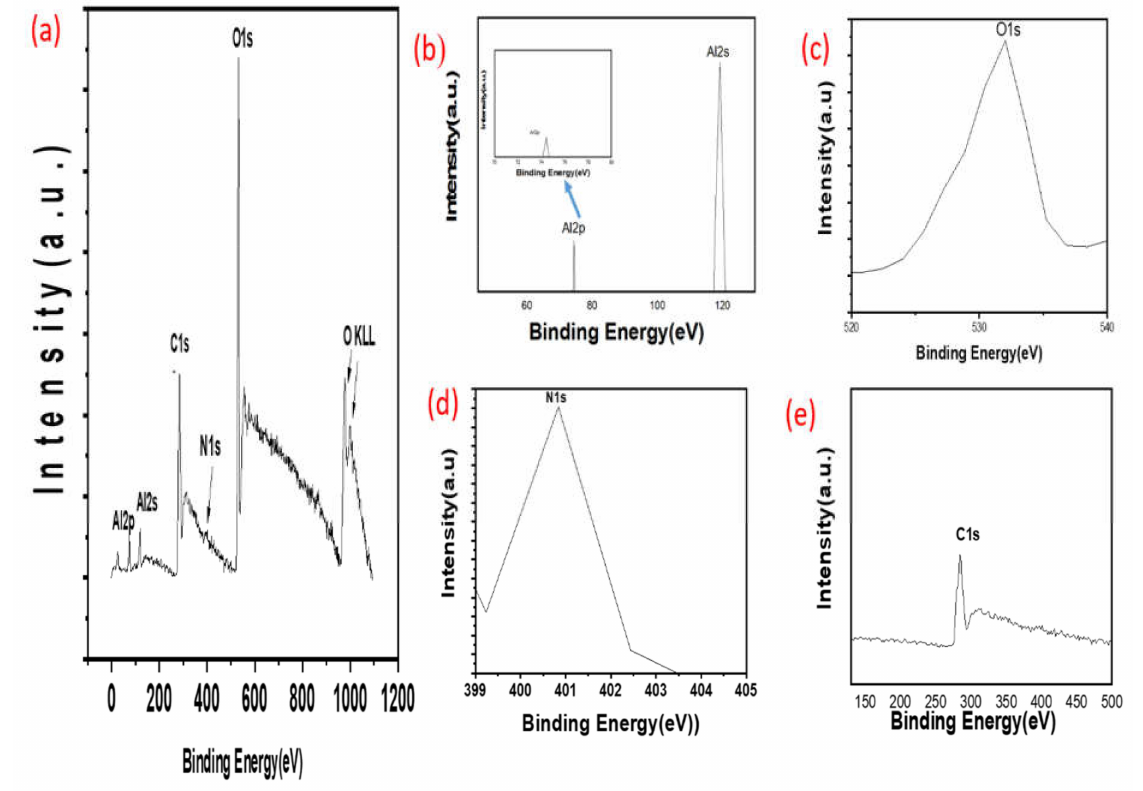
Figure 3. XPS spectrum showing binding energy for ( a ) PANI@Al-SA, ( b ) Aluminum, ( c ) Oxygen, ( d ) Nitrogen and ( e ) Carbon.